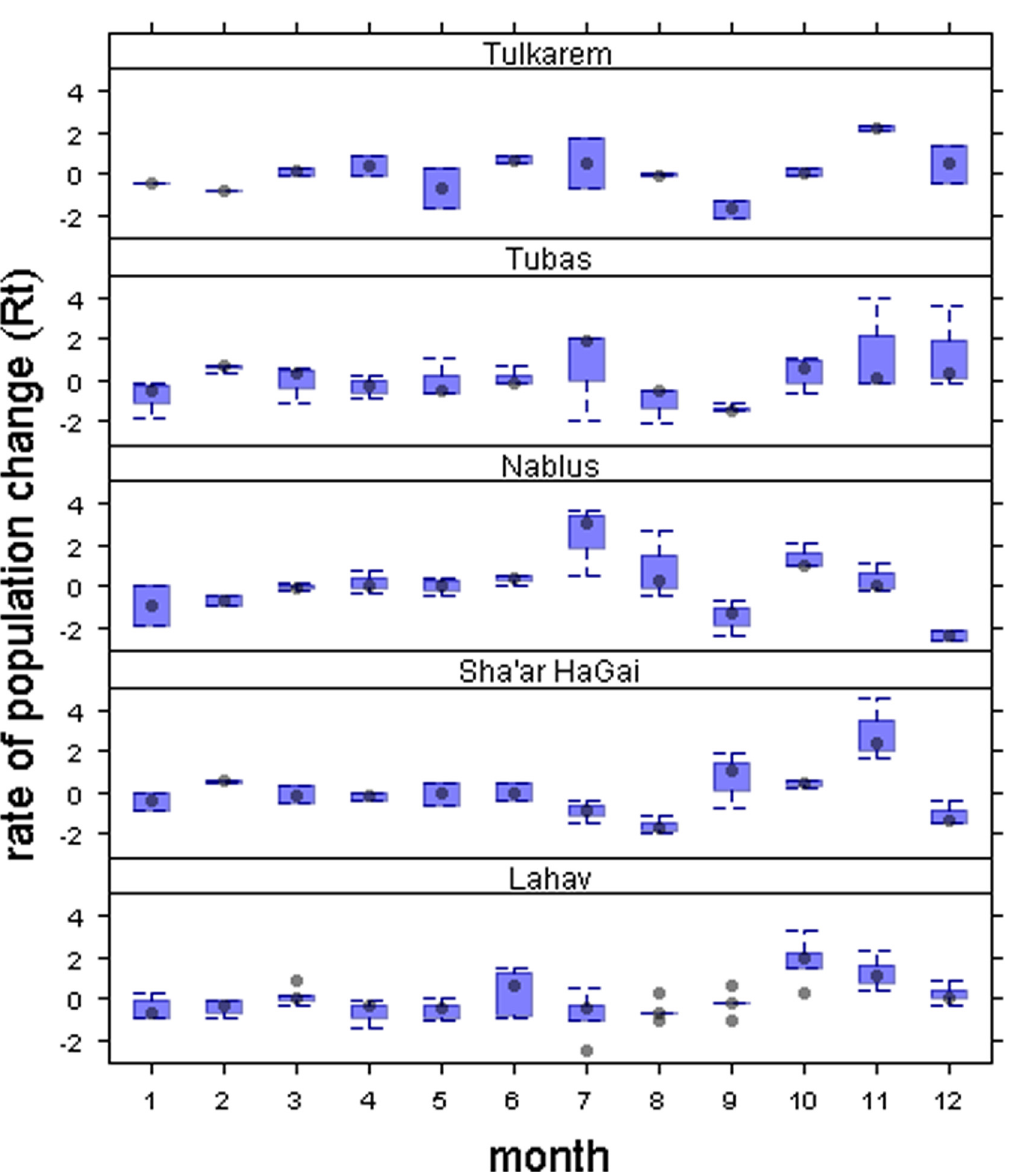
Fig 3. Monthly variation profiles. Monthly rate of population change ( R t) of Bactrocera oleae at each site. Points represent the means, boxes represent ± 1 SE and whiskers represent ± 1